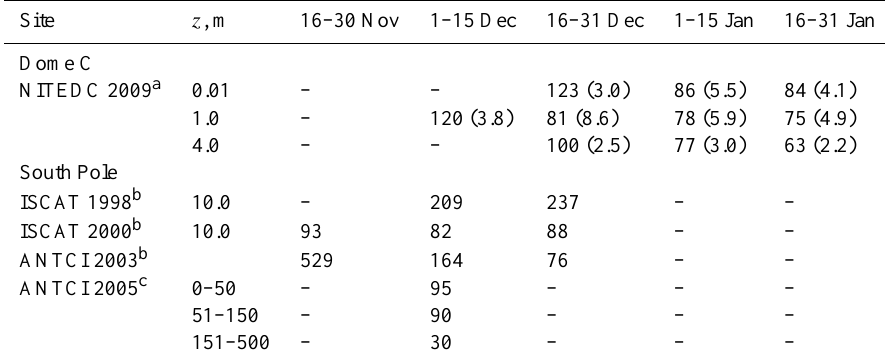
Table 3. Median NO mixing ratios (pptv) on the Antarctic Plateau.